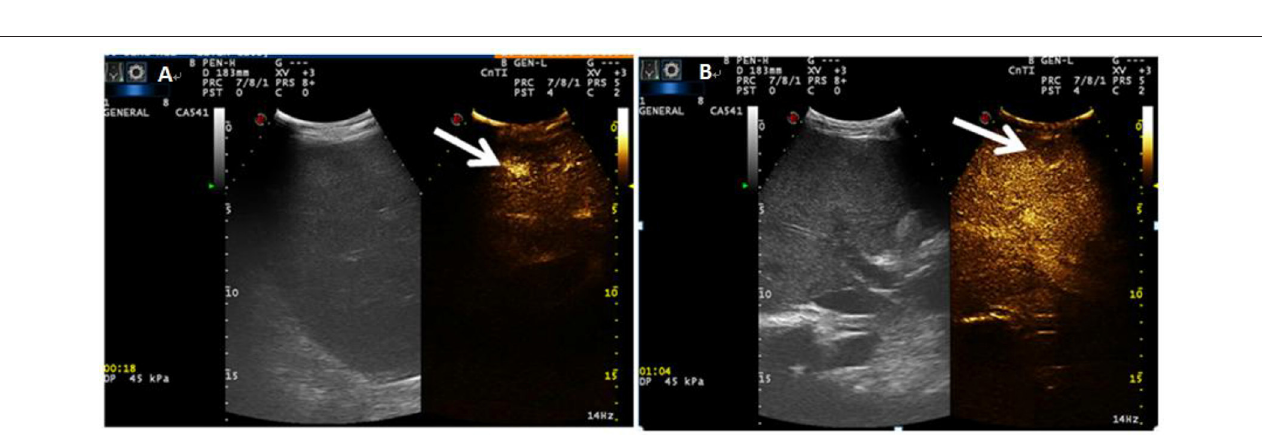
FIGURE 4 | (A) Indicates irregular hyper-enhancement in the arterial phase of the lesion, with a transient abnormal enhancement area (white arrow) in the center. (B) shows the abnormal enhancement area in the delayed phase with low enhancement (white arrow) in contrast-enhanced